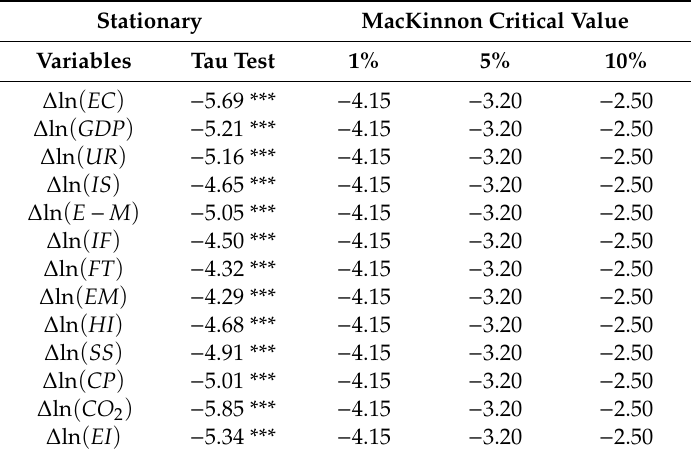
Table 1. Stationary at first di ff erence I (1).